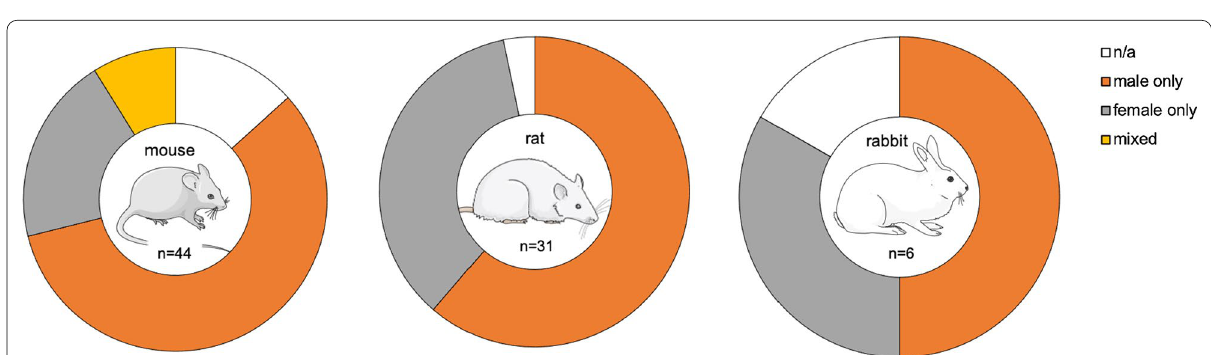
Fig. 5 Sex distribution of animals used in imaging inflammatory musculoskeletal disease